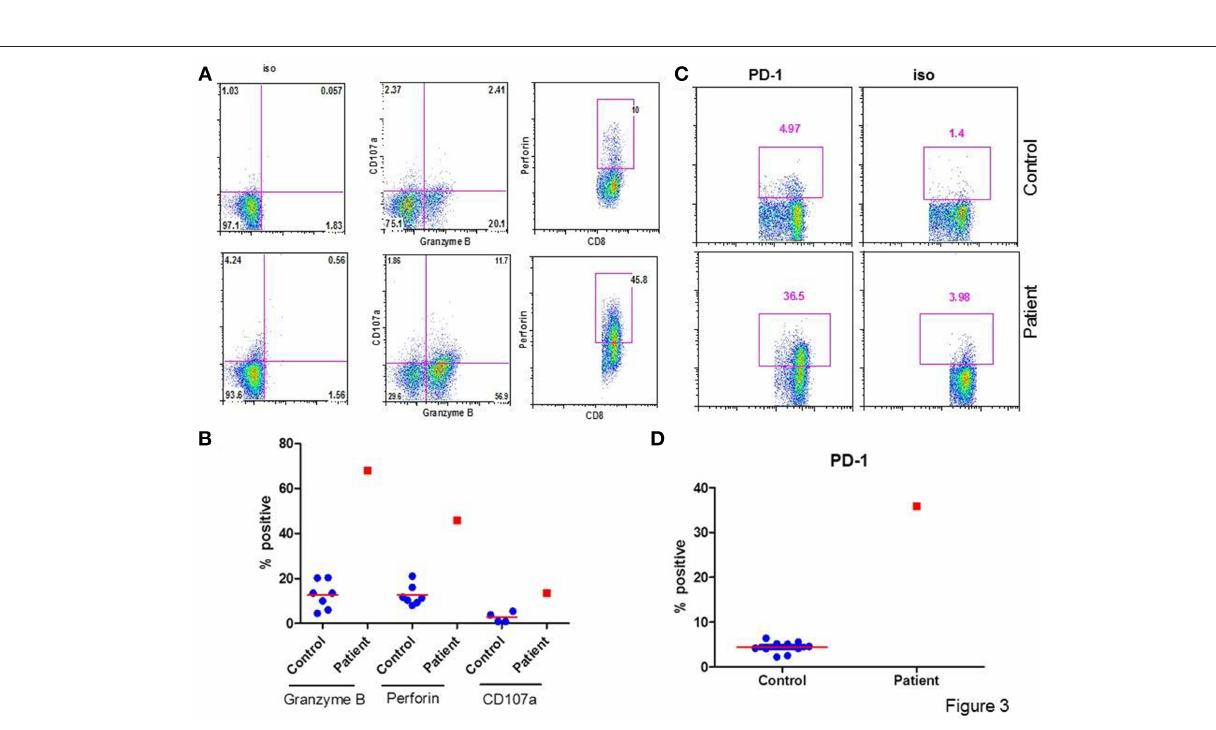
Frontiers in Immunology | www.frontiersin.org